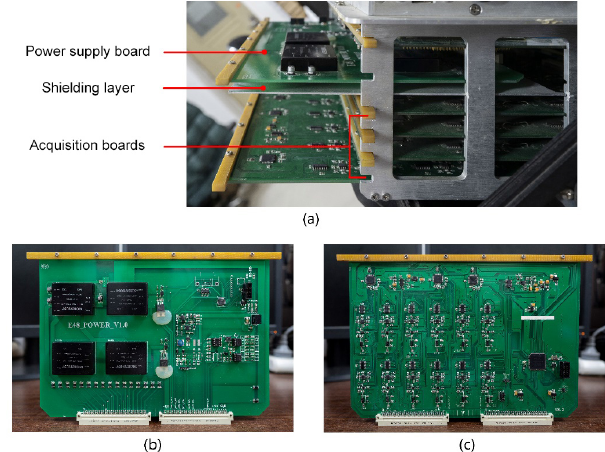
Figure 3. Internal structure of CUGB-CS48DAS and circuit boards. (a) Packaging structure of circuit boards. (b) Realization of the power supply board. (c) Realization of the acquisition board with 12